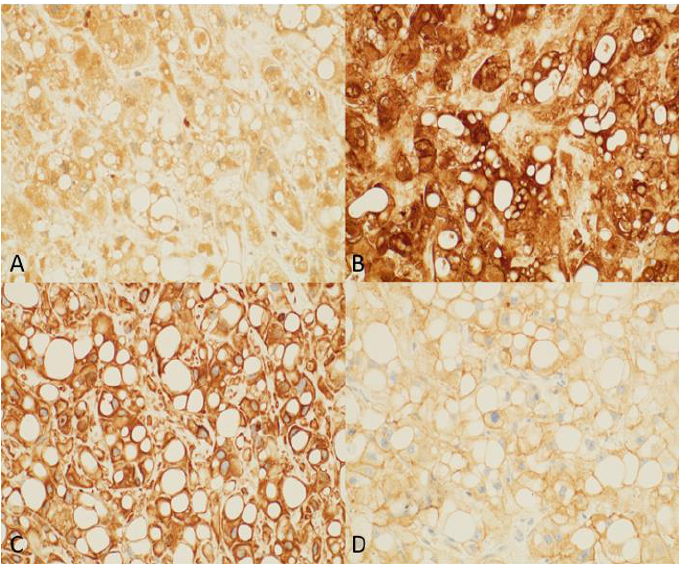
Figure 3. ( A ) S100 (20 × ): granular cytoplasmic staining of tumor cells. ( B ) EMA (20 × ): strong and diffuse cytoplasmic and membranous staining of the lesion. ( C ) Vimentin (20 × ): Diffuse staining of tumor cells cytoplasm. ( D ) EGFR (20 × ) stain shows membranous and cytoplasmic positivity in tumor